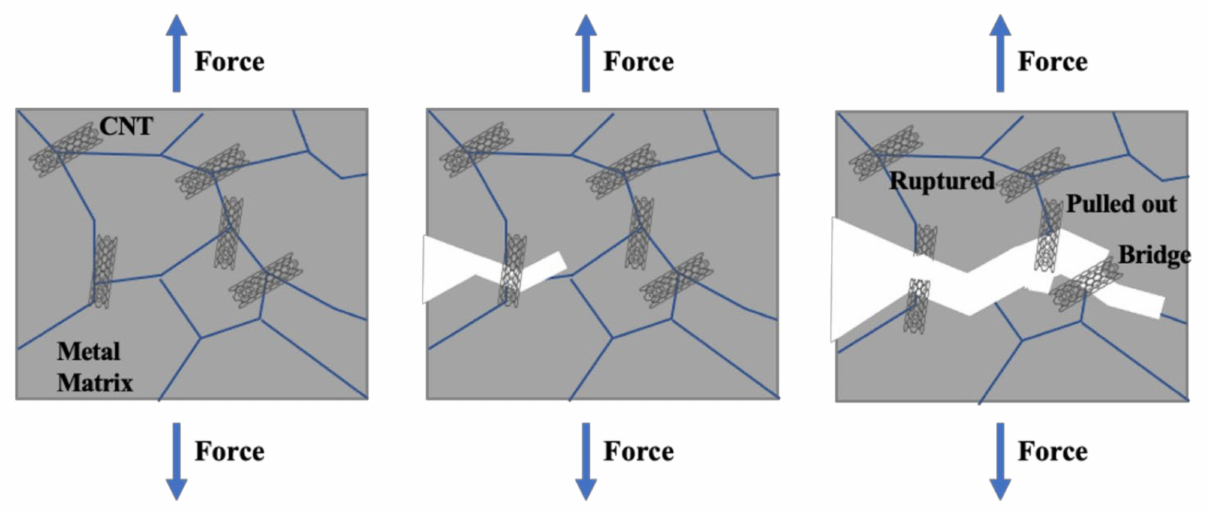
Figure 6. Schematic of the CNT behavior in the MM/CNT during tensile